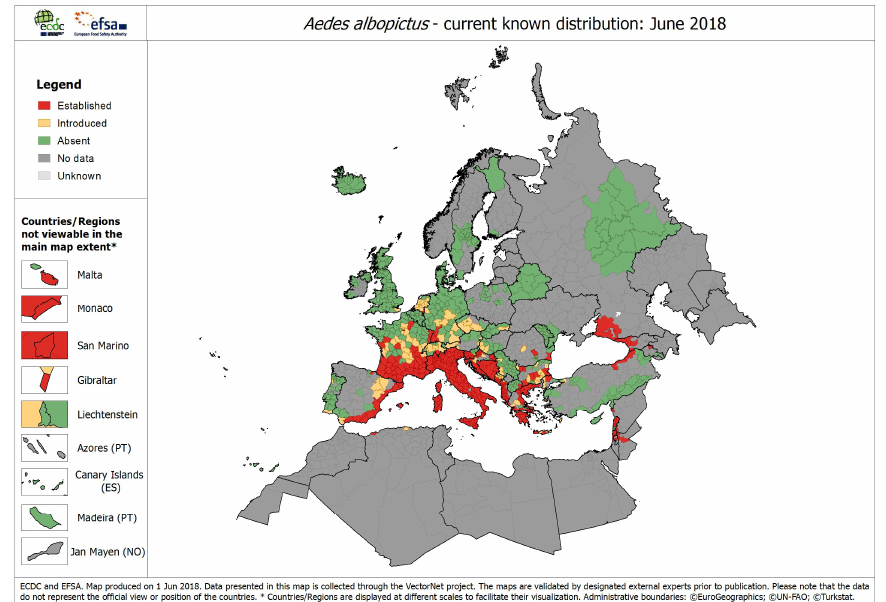
Figure 1. The current distribution of Aedes albopictus in Europe in June 2018 [21]. Established (red)—refers to an established population (evidence of reproduction and overwintering) of the species has been observed in at least one municipality within the administrative unit; Introduced (yellow)—the species has been detected (but without confirmed establishment) within the administrative unit; Absent (green)—field surveys or studies on mosquitoes were conducted but the species has not been detected within the administrative unit; No data (dark grey)—no sampling has been performed and no data on the species is available within the administrative unit; and Unknown (light grey)—it is unknown whether there are field studies on this species within the administrative unit.